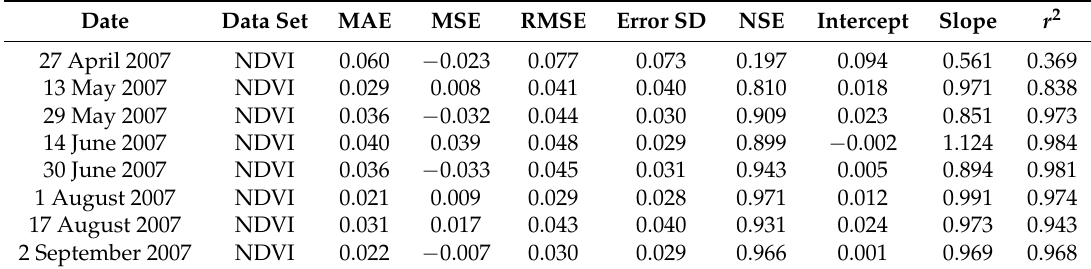
Table 2. Error and correlation statistics for full scene difference of observed and predicted Normalized Difference Vegetation Index (NDVI) values. The STARFM-predicted synthetic image was created using two pairs of training data.